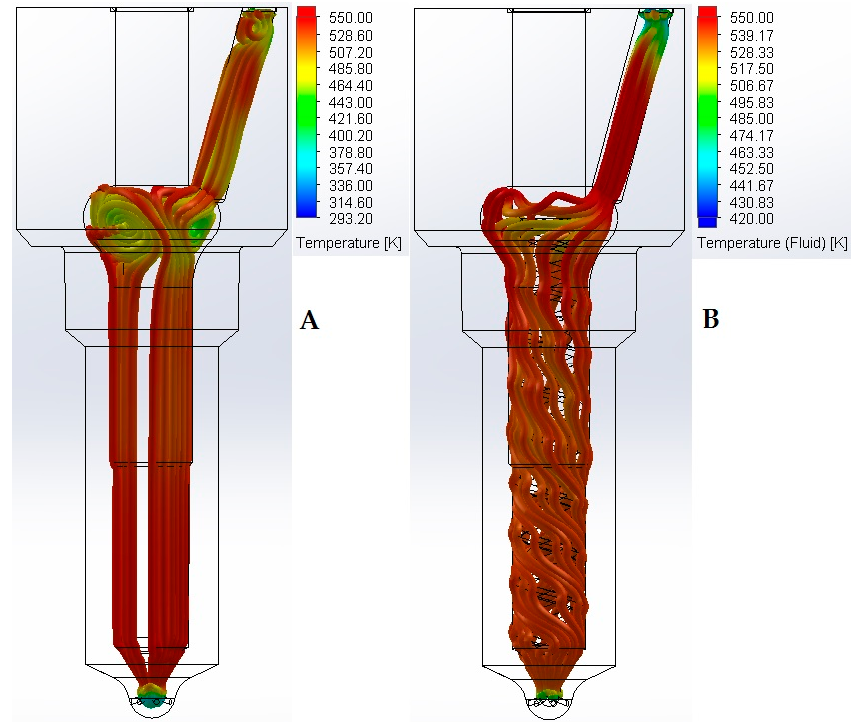
Figure 9. The results of preliminary simulation studies of the flow and temperature distribution of the fuel through the standard and modified atomizer. Flow parameters: injection dose: 1.2 mm 3 /H, injection time: 260 µ s, pressure in the system: 80 MPa. ( A ) Standard atomizer; ( B ) modified atomizer.